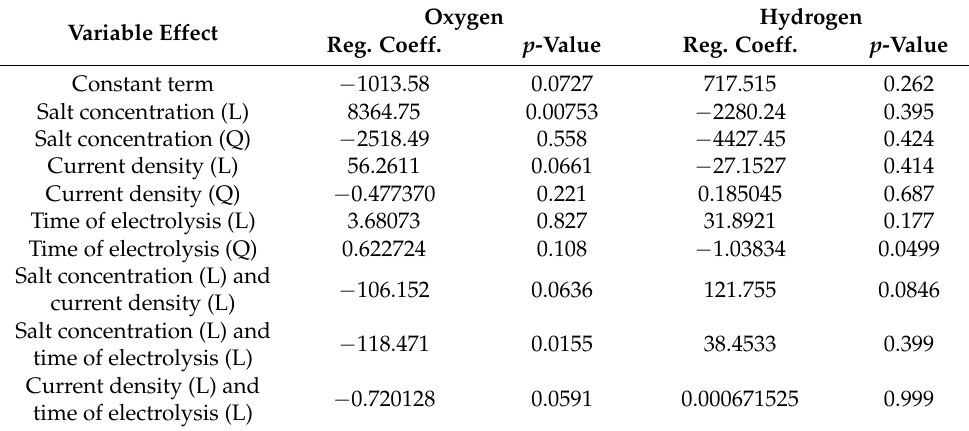
Table 3. Regression coefficients and corresponding p -values for the full statistical model for both oxygen and hydrogen bubbles. L represents the linear effect; Q represents the quadratic effect.